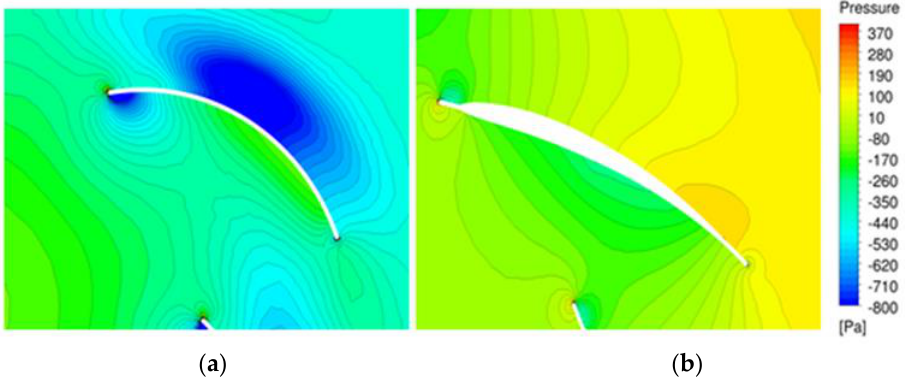
Figure 13. Static pressure distribution (at 1100 rpm): ( a ) Original model; ( b ) Optimized model.